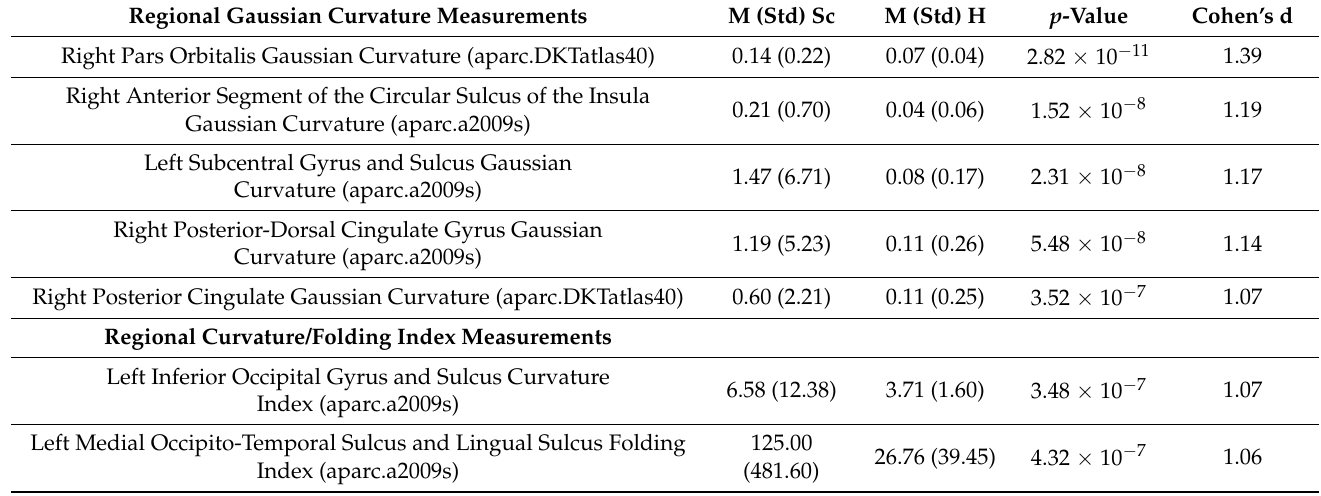
Table 2. Effect sizes for regions exhibiting statistically significant group-wise